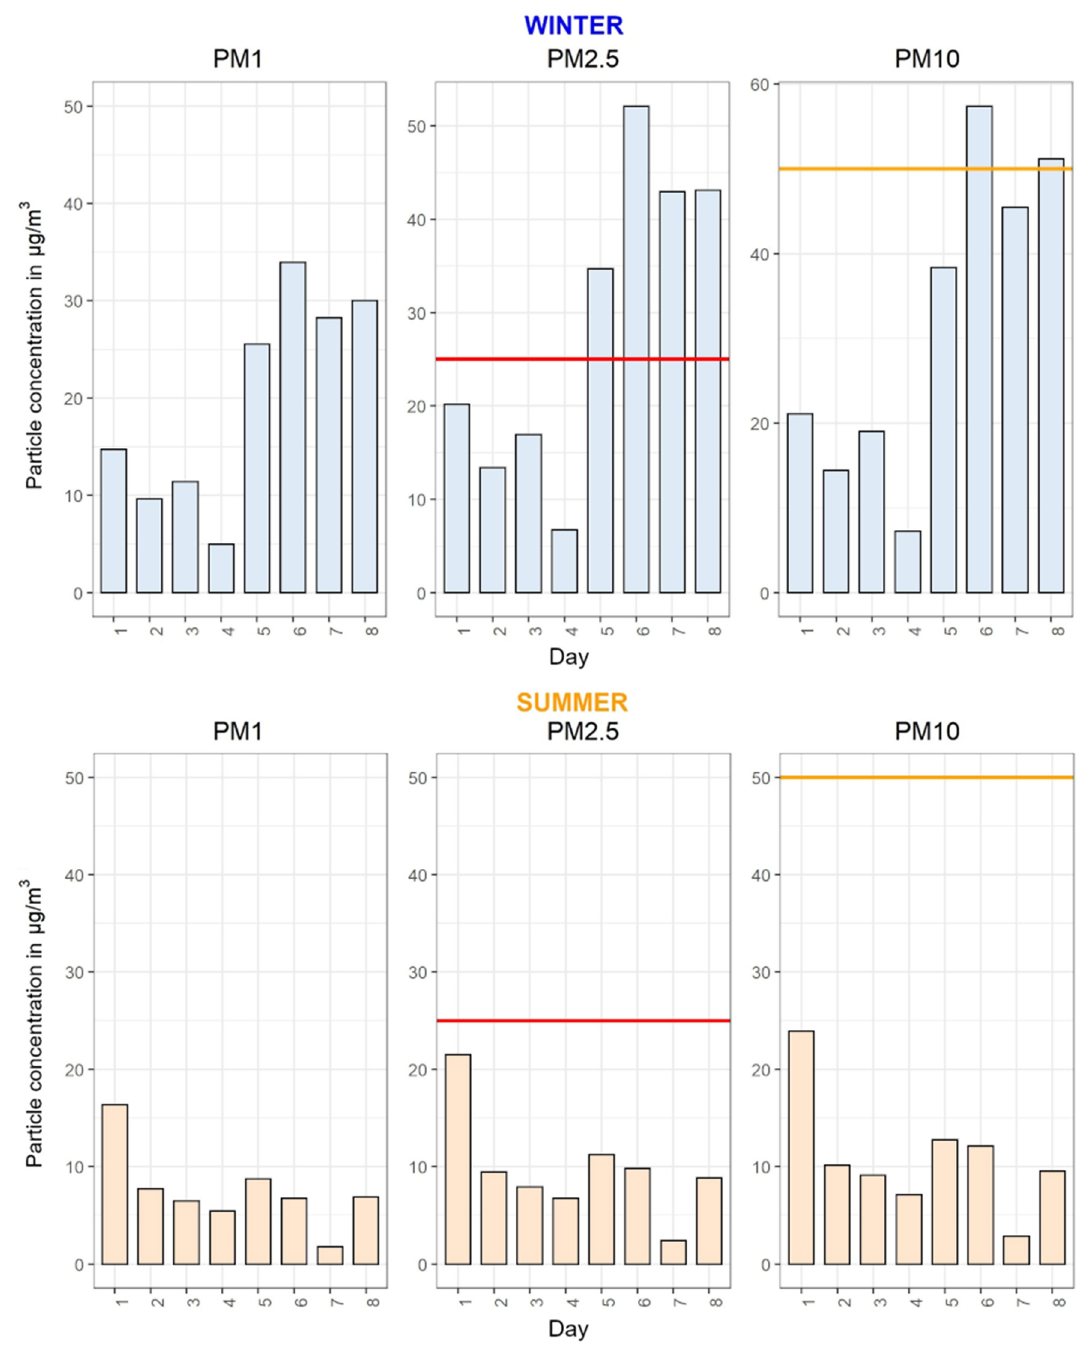
Figure 6. Faceted plots of average daily concentrations of three size classes of PM for each season, with WHO guidelines; data from PPM.